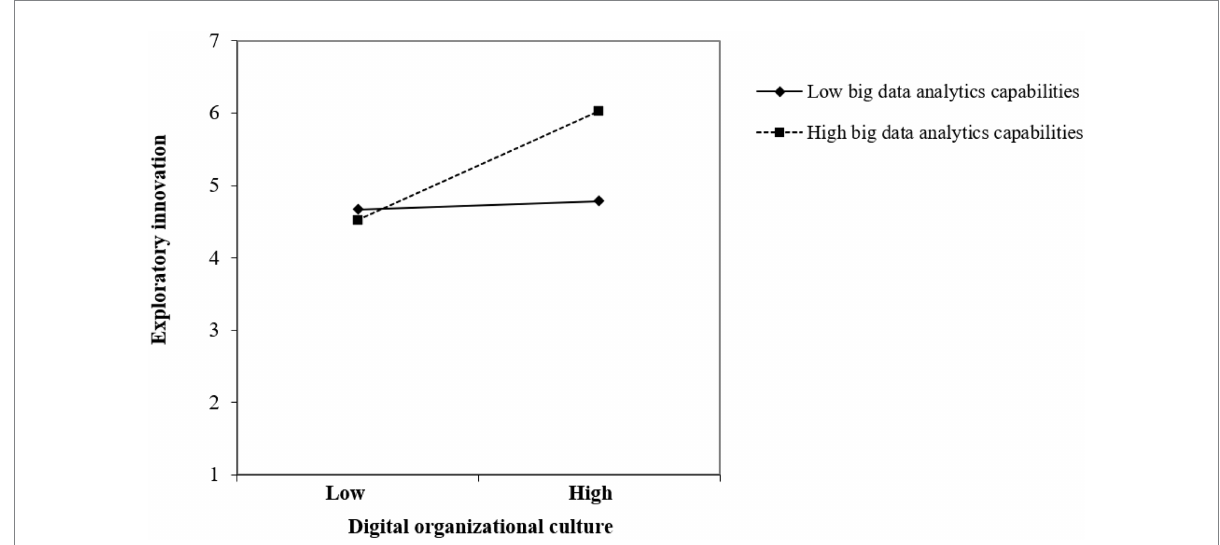
FIGURE 4 The moderating effect of big data analytic capabilities on the relationship between digital organizational culture and exploratory innovation.